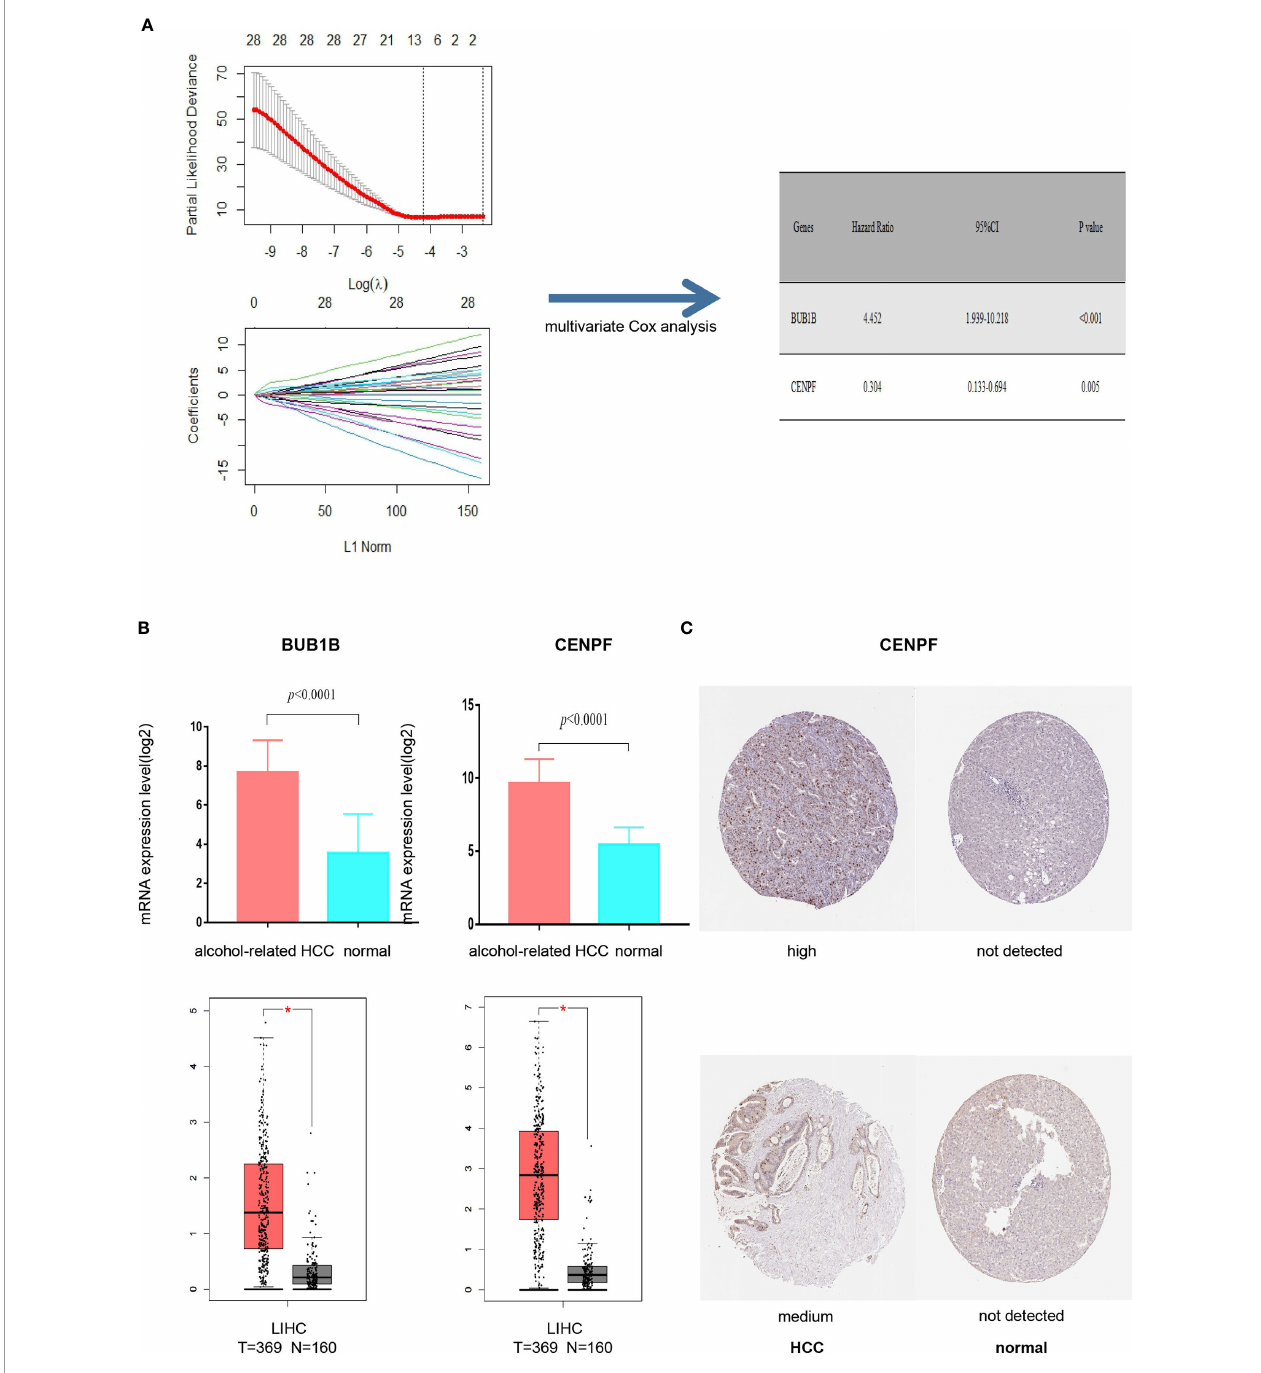
FIGURE 4 | Screening prognostic genes and expression of the genes in alcohol-related HCC and entire HCC. (A) Process of screening prognostic genes. (B) The mRNA expression levels of two genes in alcohol-related HCC and entire HCC. (C) Protein expression level of CENPF in HCC. * P <